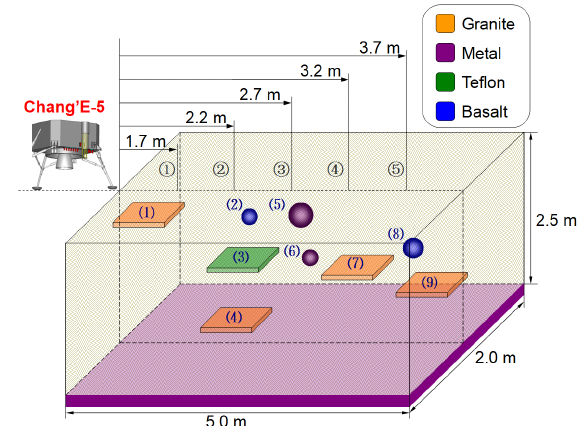
Figure 4. Model diagram of different subsurface hard objects in earth laboratory.